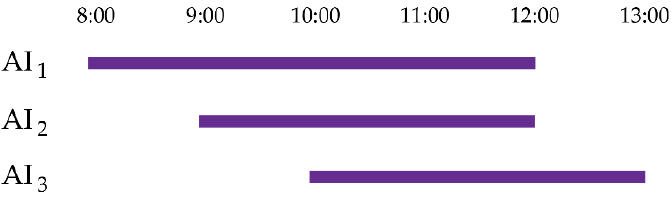
Figure 26. Activity intervals used in experiment.